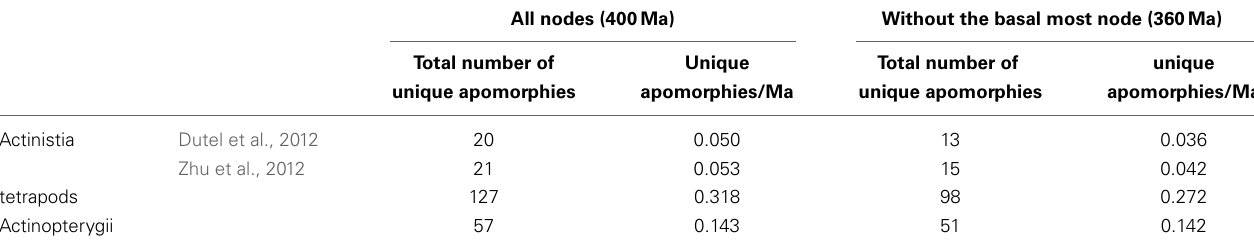
Table 1 | Total number of unique apomorphy and corresponding rates of unique apomorphy acquisition per million years for each reconstructed trees.